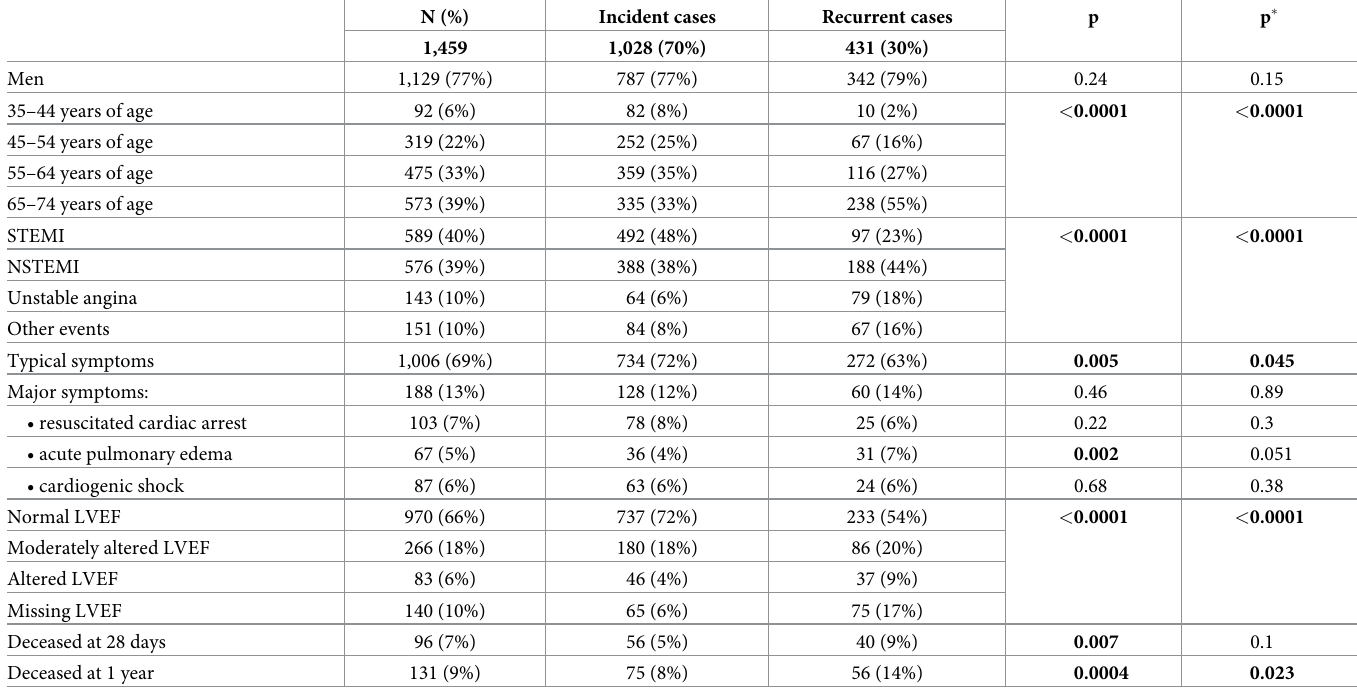
Table 1. Main characteristics of patients admitted to hospital for an incident or recurrent acute coronary